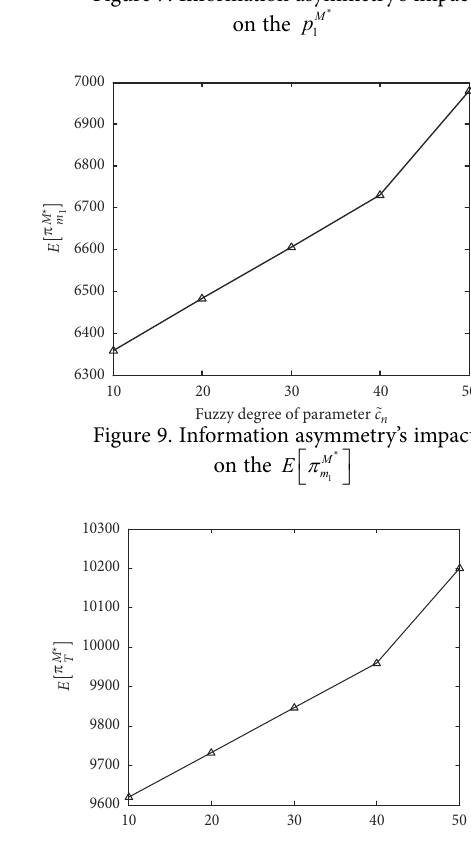
Figure 10. Information asymmetry’s impact on the